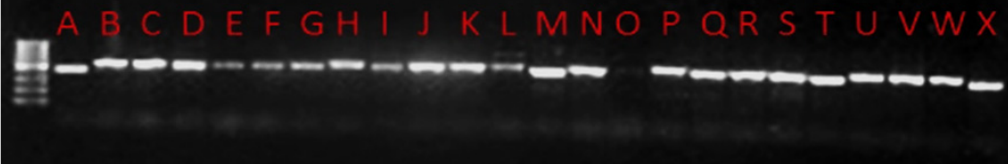
Fig. 2. LANE A , P. burtoni ; lane B, Pleosporalus sp.; lane C , P. macrostoma ; lane D , Dothidealus ; lane E, Dothideomyces ; lane F, P. macrostoma ; lane G, P. macrostoma ; lane H, A. parasiticus ; lane I, C. uredinicola ; lane J, A. parasiticus ; lane K , A. niger ; lane M , F. oxysporum ; lane N, A. parasiticus ; lane O, no DNA; Lane P, Rhizopus delemar , Lane Q, P. corylophilum ; Lane R, A. parasiticus ; Lane S , Fusarium biseptatum ; Lane T , Trichosporon insectorum ; Lane U, A. niger ; Lane V, A. niger ; Lane W, A. flavus , Lane X, Trichosporon